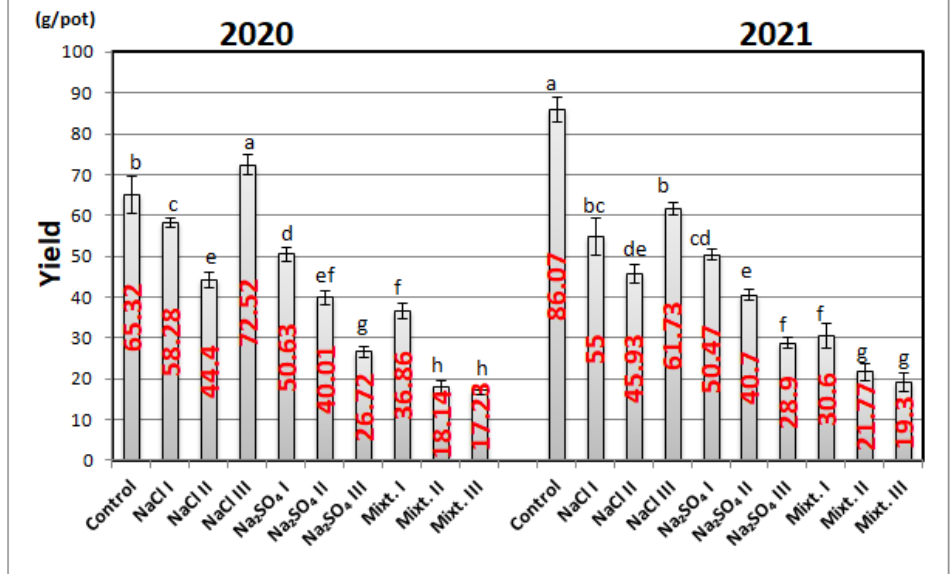
Figure 2. Average yield per vegetation pot for N. cataria L. for all variants and both years with significant differences at 0.001 level indicated with letters.